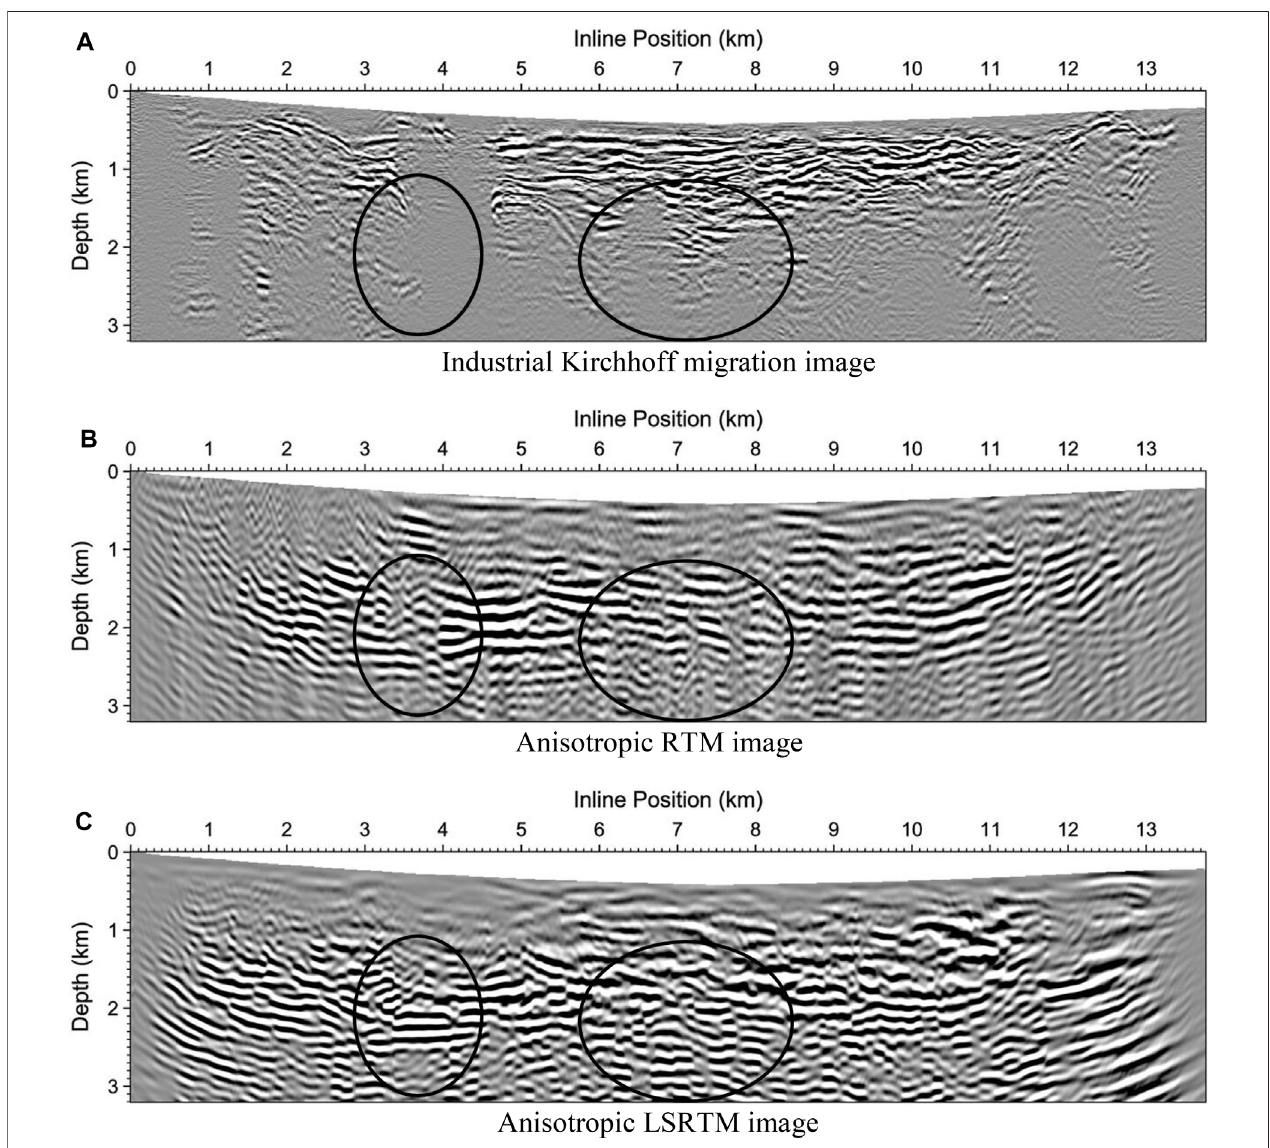
FIGURE 11 | Subsurface migration images of Line 2 at Pirouette Mountain produced using various migration methods: (A) Industrial Kirchhoff migration, (B) Anisotropic RTM, (C) Anisotropic LSRTM. The images within the ellipse regions in (C) are much better than those in (B) , and are not imaged in (A) .